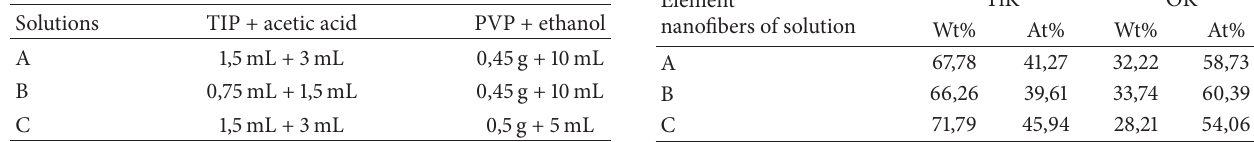
Table 1: Variations and different amounts of precursor and poly- meric matrix.